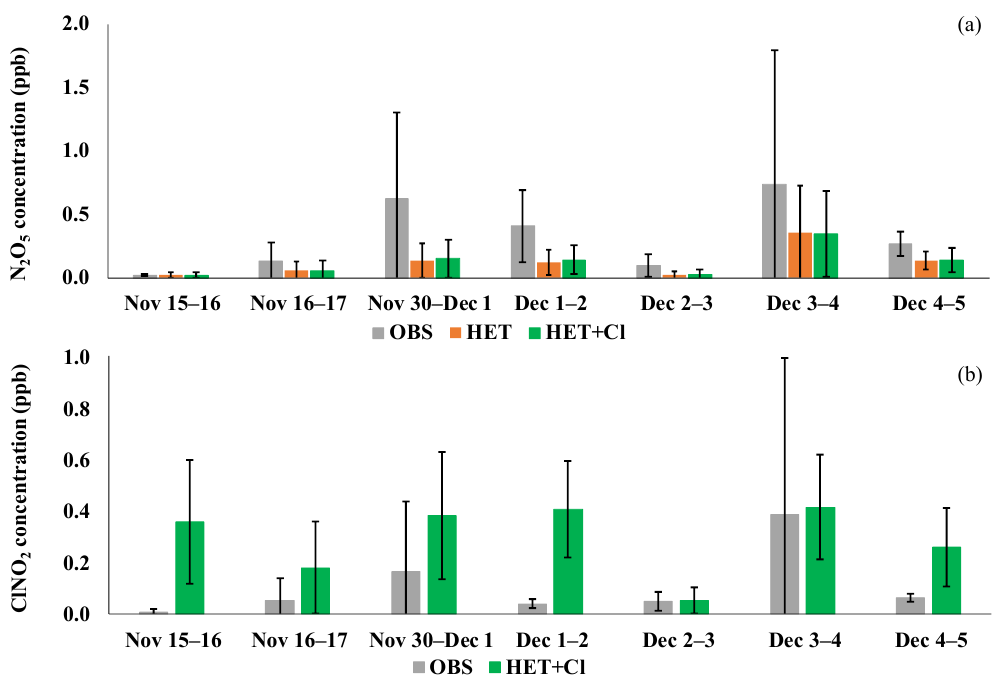
Figure 2. Comparison of simulated and observed average (a) N 2 O 5 and (b) ClNO 2 concentrations each night at the TMS site. Error bars represent the standard